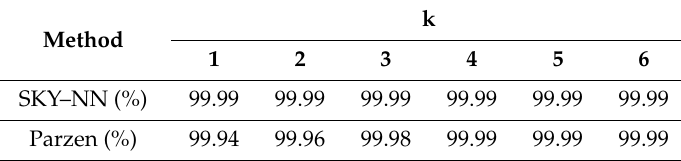
Table 8. Opposite skyline on the synthetic Dataset I.